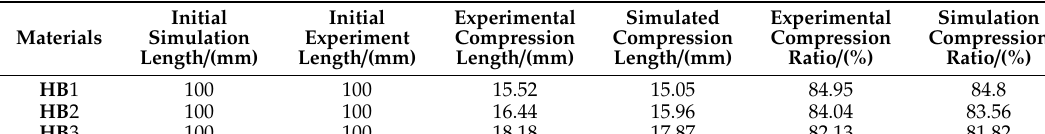
Table 2. Experiment compression ratio.